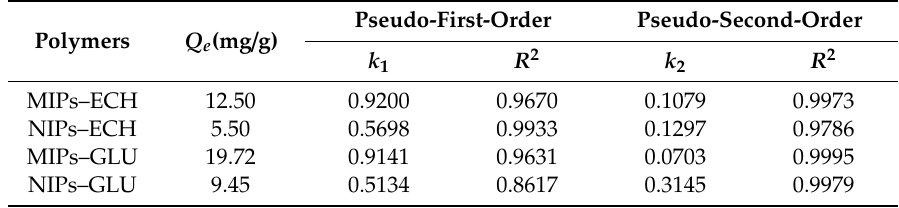
Table 1. Kinetic parameters of the pseudo-first-order and pseudo-second-order equations for ALA adsorption onto the MIPs and NIPs adsorbents.